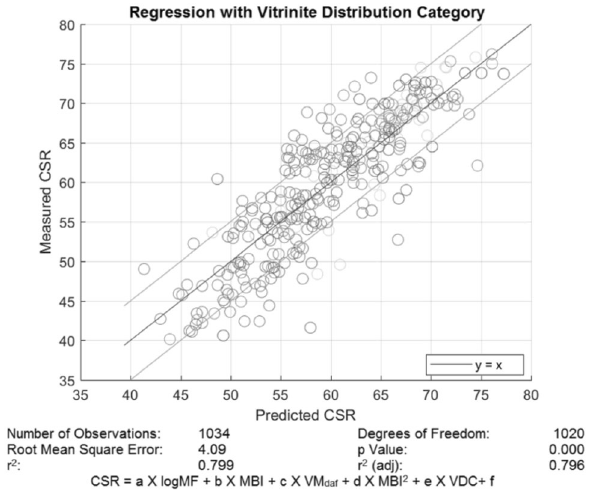
Fig. 6 V-group regression blend fit and overall model statistics for both single coals and blends. Lines for y = x and y = x ± 5 are shown to aid comparison. For ease of interpretation, the figure displays only the results of blend fit, with the statistics reported developed on a model including both single coals and blends, including the VDC